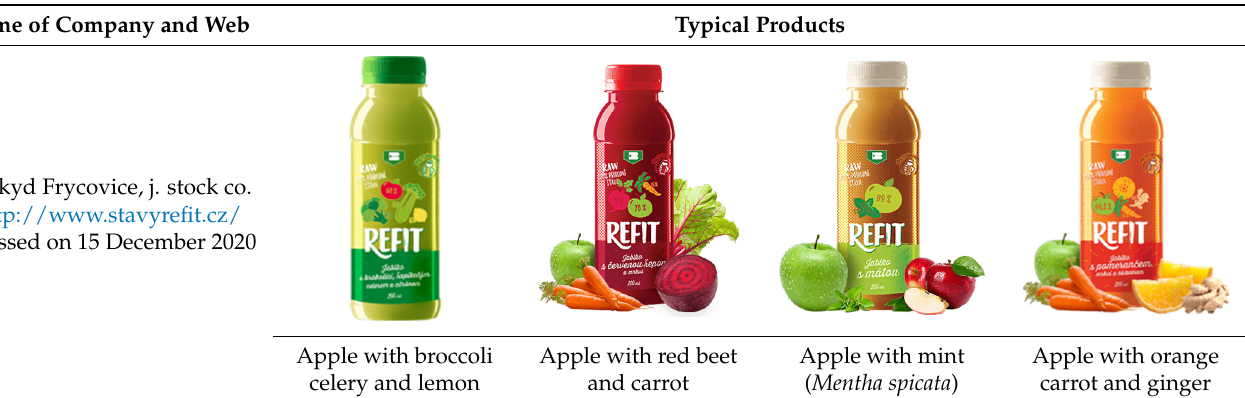
Table A3. High pressure treated products by the company Coldpress Foods.